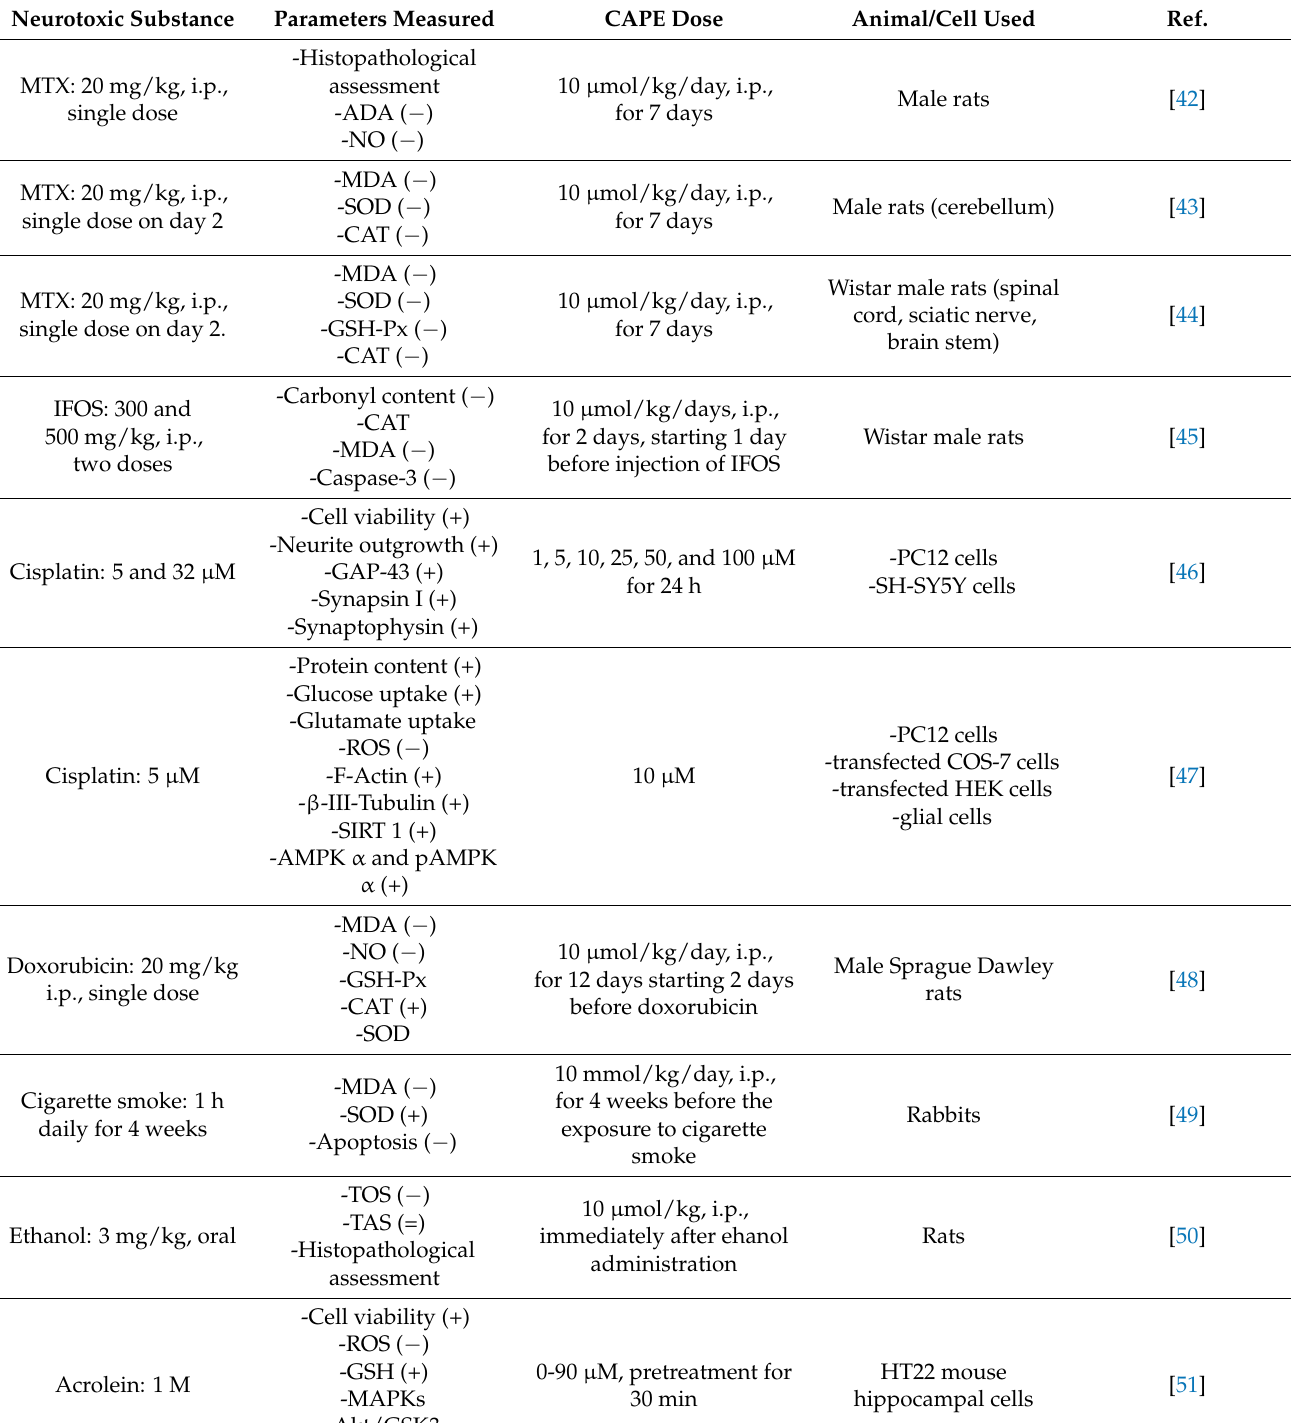
Table 2. CAPE protective effects against different neurotoxic substances. Where applicable, the effect of CAPE on the parameters measured is reported between parentheses (+, − or =). CAPE Dose